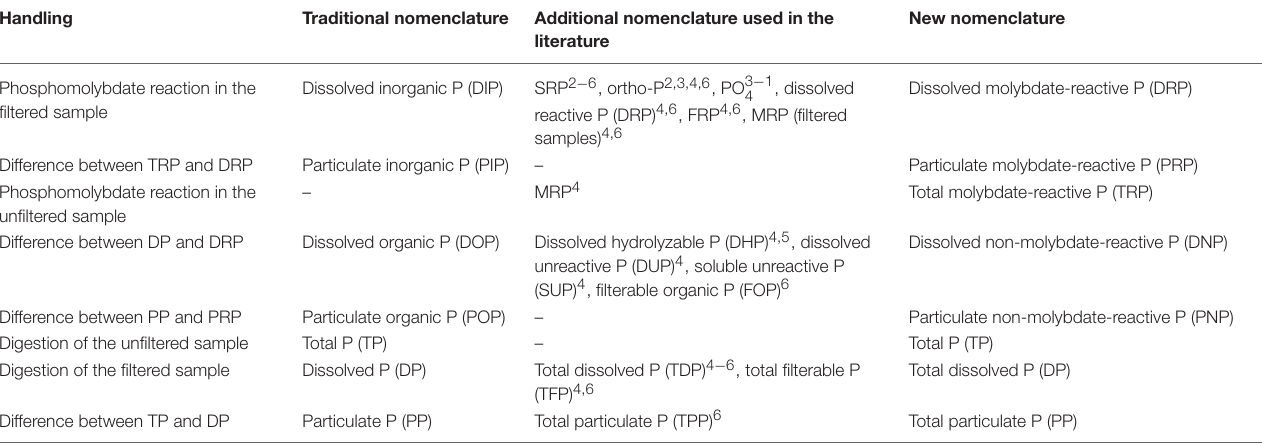
TABLE 5 | Overview of the various nomenclatures and the terms used to detect the various phosphorus (P) categories.